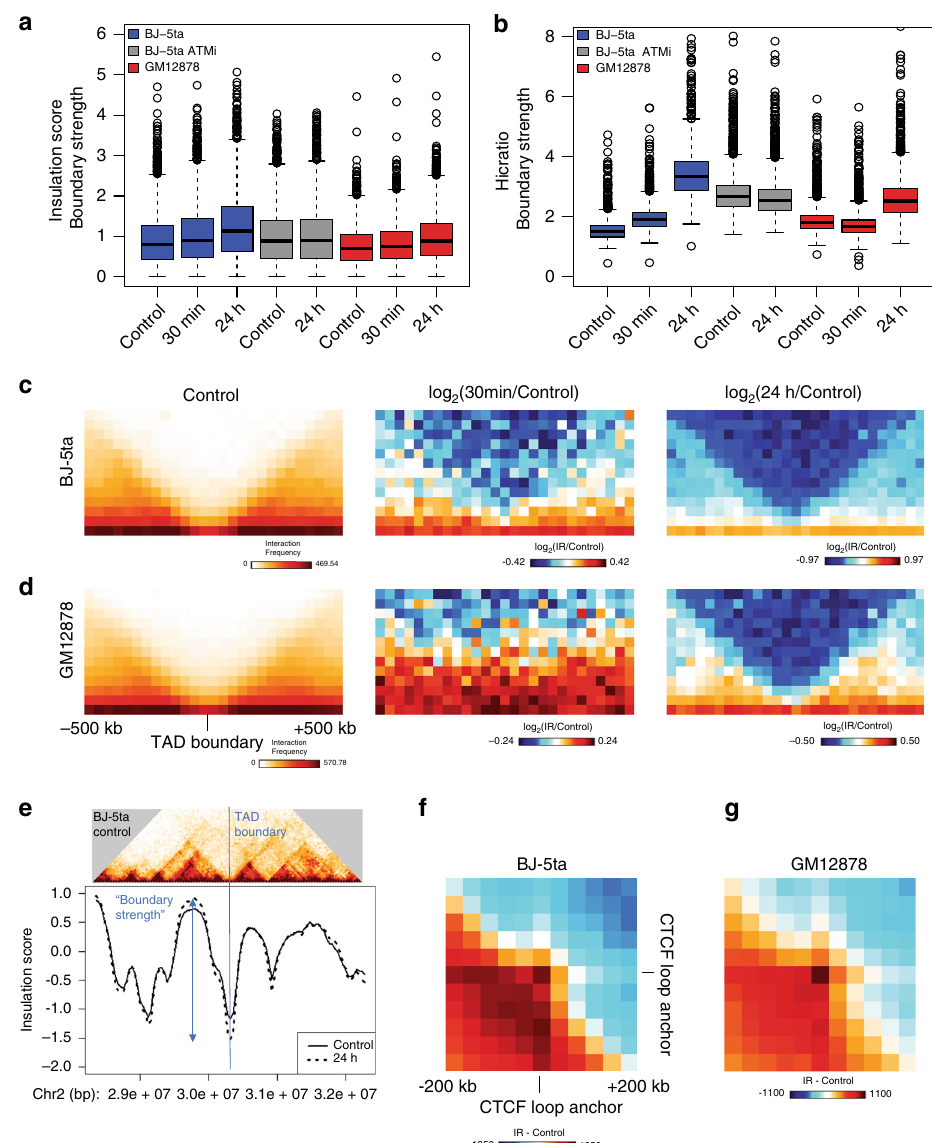
Fig. 4 TAD boundary strength and CTCF loop strength both increase after IR. a, b TAD boundary strength boxplots calculated using both the InsulationScore ( a ) (Number of TAD boundaries (N) BJ-5ta = 1232, BJ-5ta – ATMi = 2010, GM12878 = 1091) and Hicratio (Number of TAD boundaries (N) BJ-5ta = 1298, BJ-5ta – ATMi = 2868, GM12878 = 1878) ( b ) methods for both BJ-5ta (blue) and GM12878 (red) cells. Gray represents the lack of TAD strength increase at 24 h after IR when BJ-5ta cells were treated with ATM inhibitor. Boxes represent the upper and lower quartiles with the center line as the median. Upper whiskers extend 1.5 × IQR beyond the upper quartile, and lower whiskers extend either 1.5 × IQR below the lower quartile or to the end of the dataset. A Wilcoxon signed rank test with continuity correction determined that both BJ-5ta and GM12878 control boundary strength distributions were statistically less than their 30 min and 24 h counterparts ( p < 2.2 × 10 − 16 ). c, d Aggregate contact maps (40 kb bins) at TAD boundaries called by the InsulationScore method with strength greater than 1 in BJ-5ta ( c ) and GM12878 ( d ): Control (Left), log2(30 min/control) (Middle), and log2(24 h/ Control) (Right). e Example of strengthened TAD boundary. Top — BJ-5ta control Hi-C contacts around a TAD boundary from chr2. Bottom — InsulationScore pro fi le across the region showing the sharper dip in 24 h (dotted) vs. control (solid) at the TAD boundary. f, g Subtracted heatmaps for 24 h minus Control aggregate interactions around loop anchors with CTCF sites (3851 total loops) for BJ-5ta ( f ) and GM12878 ( g